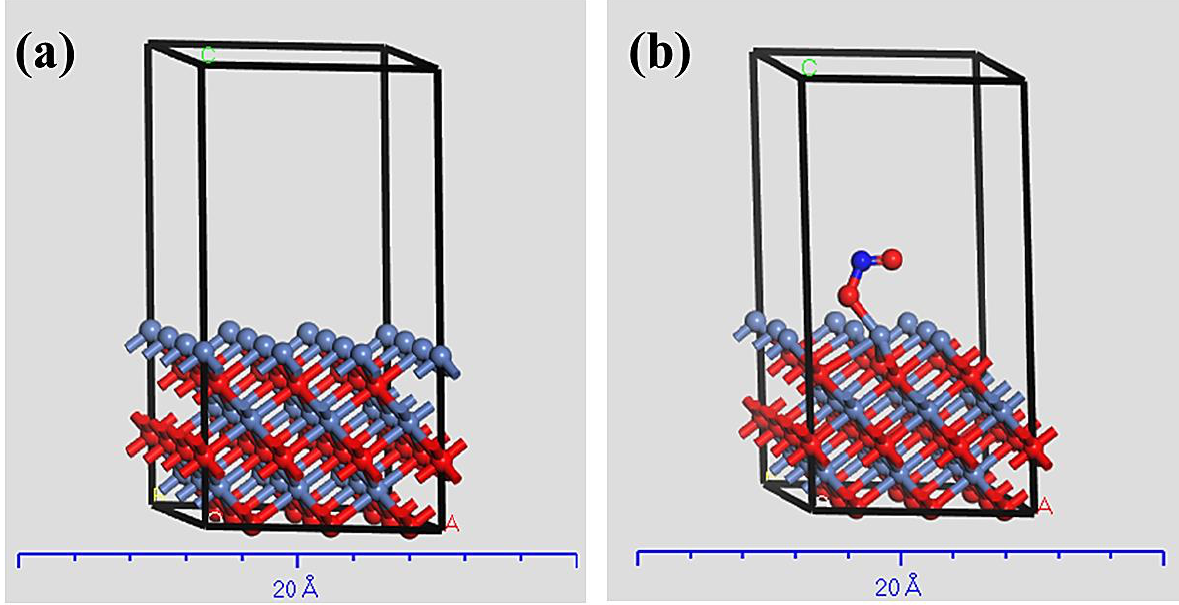
Figure 5. ( a ) Clean NiO{100} surface, ( b ) N 𝑂 2− adsorbed on NiO{100} surface.